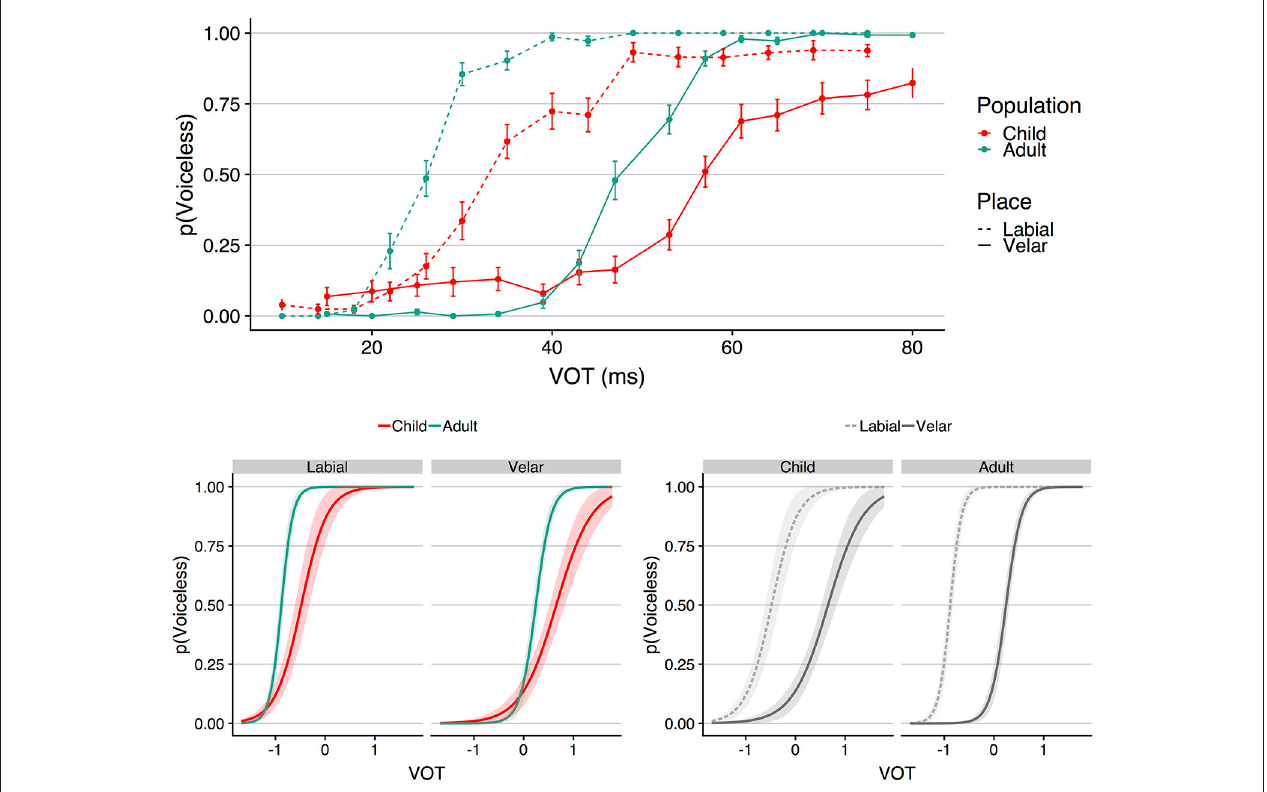
FIGURE 3 | The (Top) shows mean proportion voiceless responses as a function of VOT (ms) for each population at each place of articulation. Error bars indicate standard error of the mean. The (Bottom) shows the results of the GLMM; VOT (in ms) was entered into the model scaled and centered around the mean, which is shown as 0 on the abscissa for the plots on the bottom panel. At left, place of articulation is faceted to facilitate visualization of the interaction between VOT and population. At right, population is faceted to facilitate visualization of the place of articulation effect in each population. The shaded regions around the functions in the bottom panel indicate the 95% confidence interval